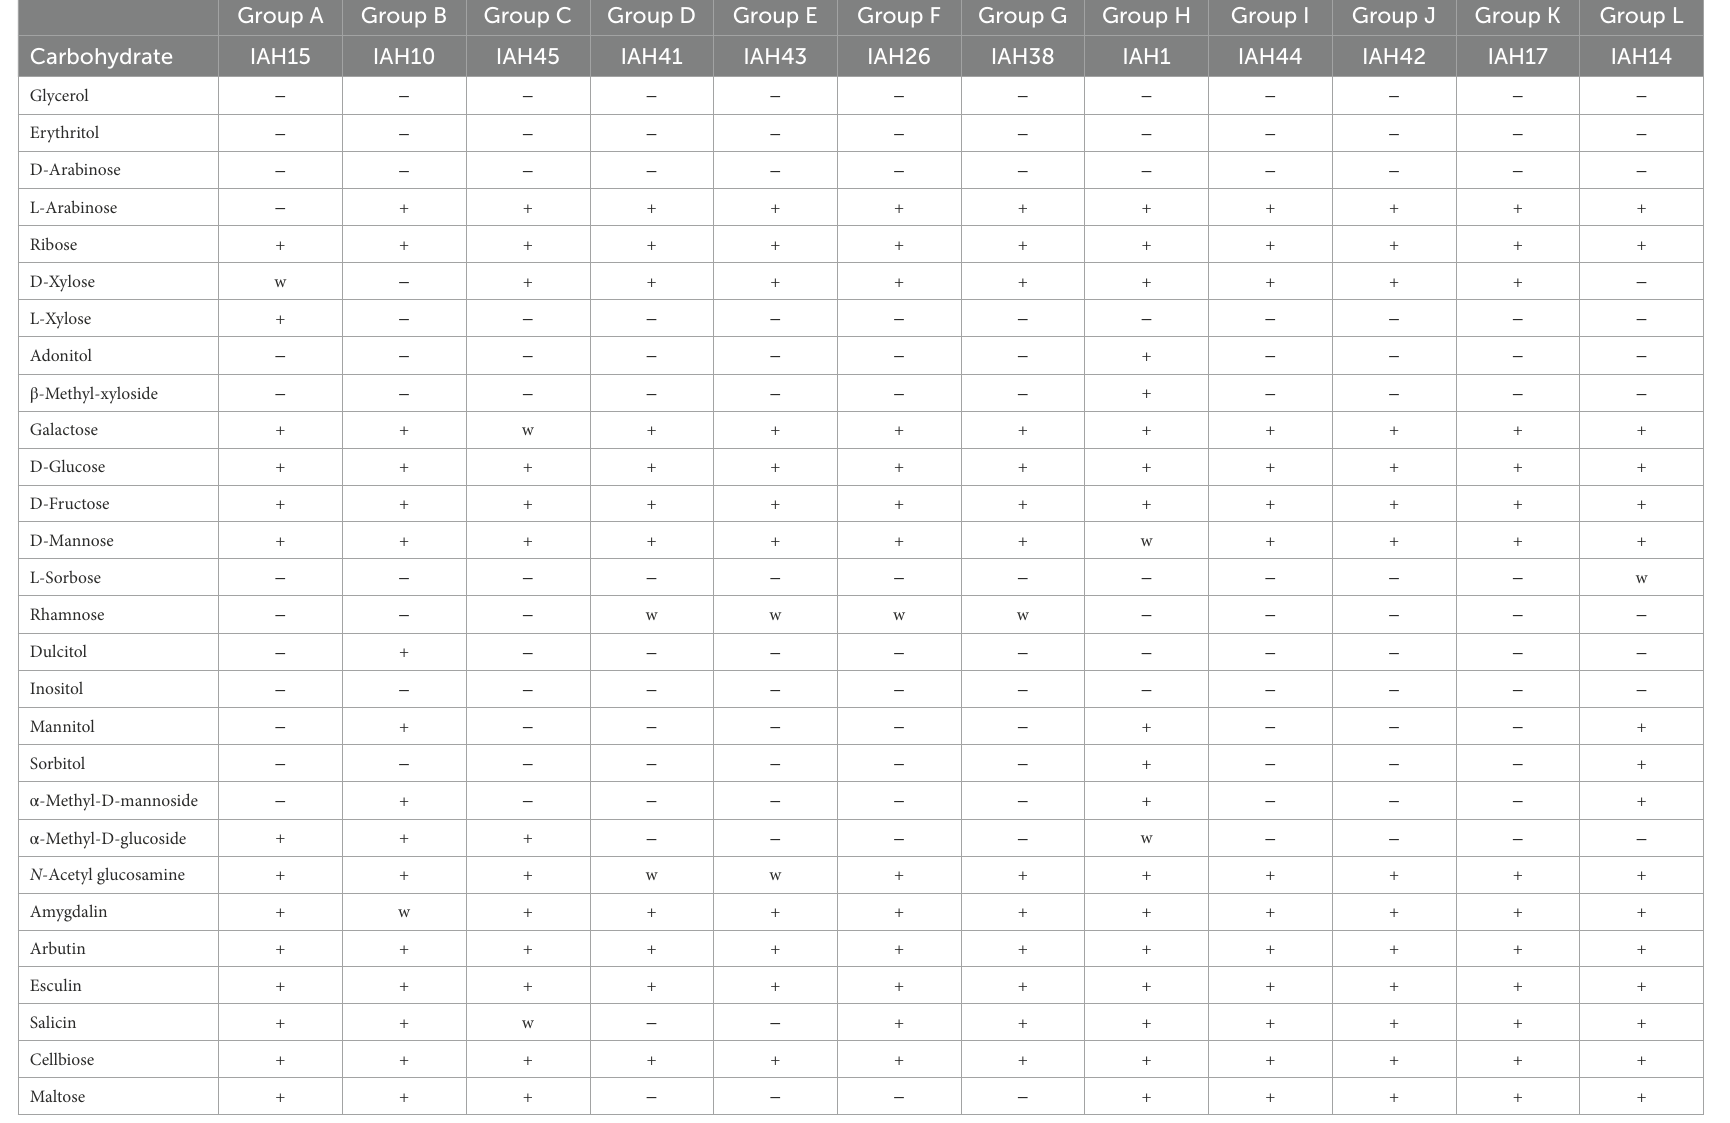
TABLE 6 API 50 CH (bioMerieux, Tokyo, Japan) characteristics of representative strains isolated from natural